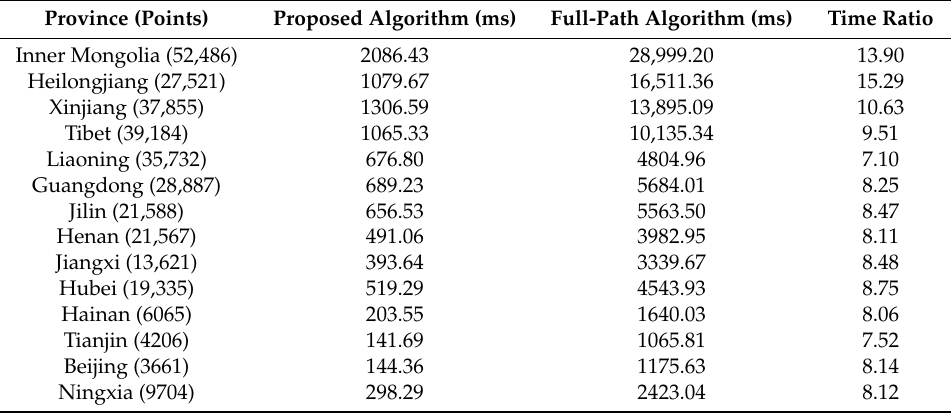
Table 2. Computation speed statistics for the full-path and proposed algorithms. Province